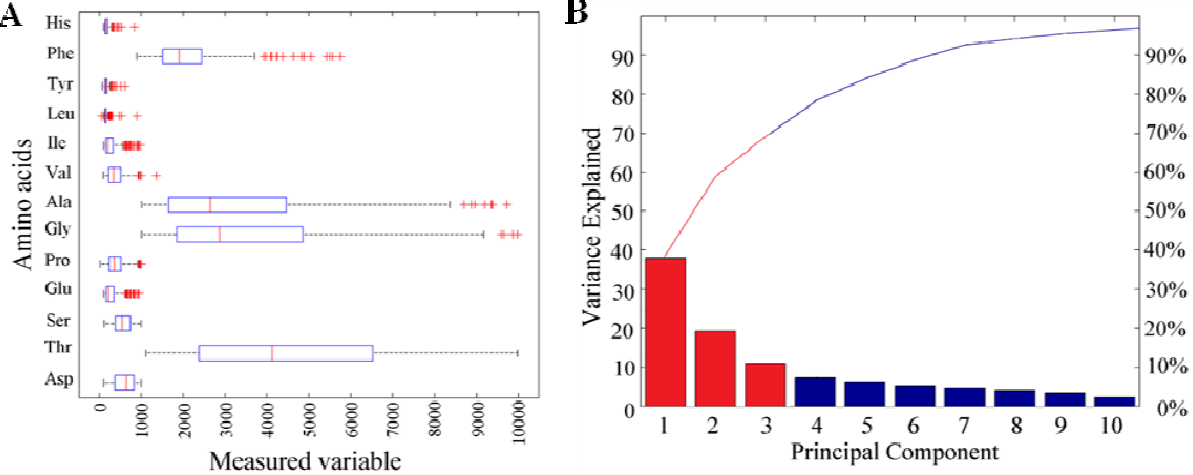
Figure 1. Content of alanine (Ala), aspartic acid (Asp), glycine (Gly), glutamic acid (Glu), histidine (His), isoleucine (Ile), leucine (Leu), phenylalanine (Phe), proline (Pro), serine (Ser), threonine (Thr), tyrosine (Tyr) and valine (Val). Liquid chromatography apparatus AAA 400 (Ingos, Czech Republic) was used for determination of amino acids. ( A ) Box plot graphs of range values of content of amino acids of interest (mM, the average, mean and variance are expressed); ( B ) representation of the content of amino acids by the use of ten principal components.